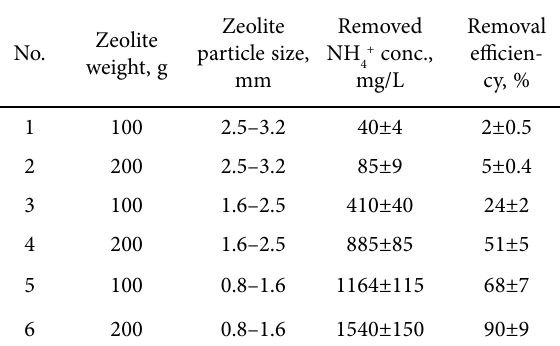
Table 3. Batch test (I) experiment results